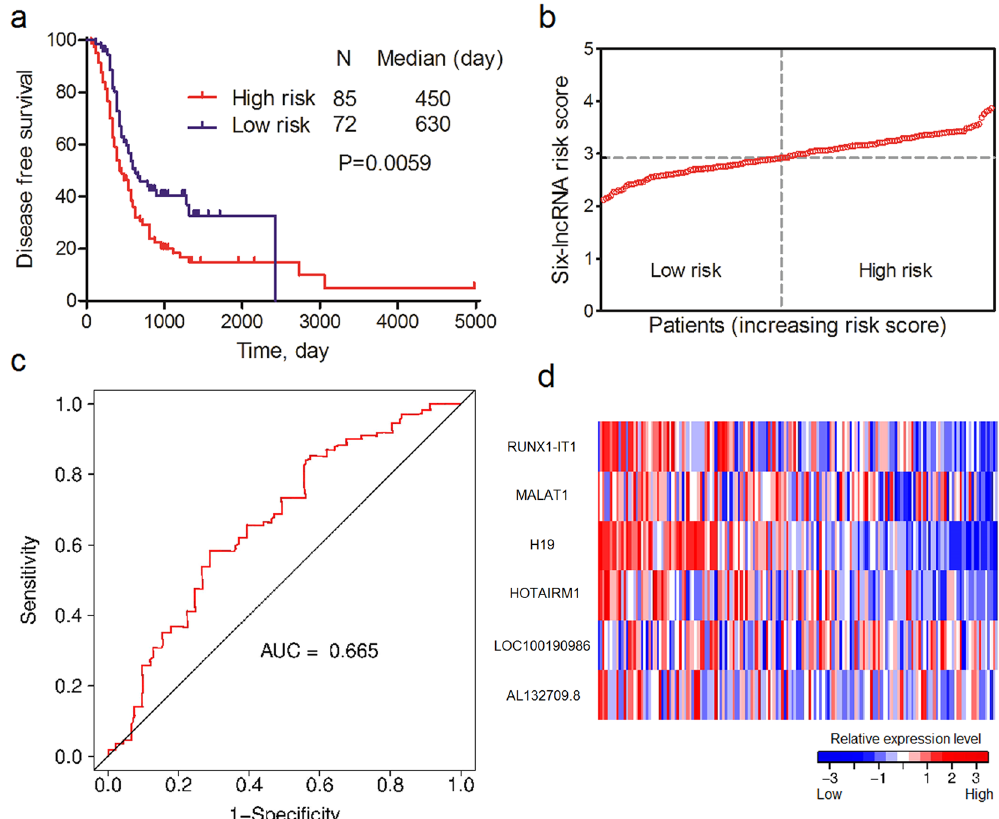
Figure 2. Association between the six-lncRNA signature and DFS of OvCa patients in GSE9891 internal validation cohort. ( a ) K-M curve of DFS between low- and high-risk patients. ( b ) Risk scores of each patient in the GSE9891 internal validation cohort (sorted by risk score). ( c ) Time-dependent ROC curve analysis of the DFS prediction based on the risk score with three years as the time point. ( d ) Expression heat map of six lncRNAs in OvCa patients in the GSE9891 internal validation cohort (sorted by risk